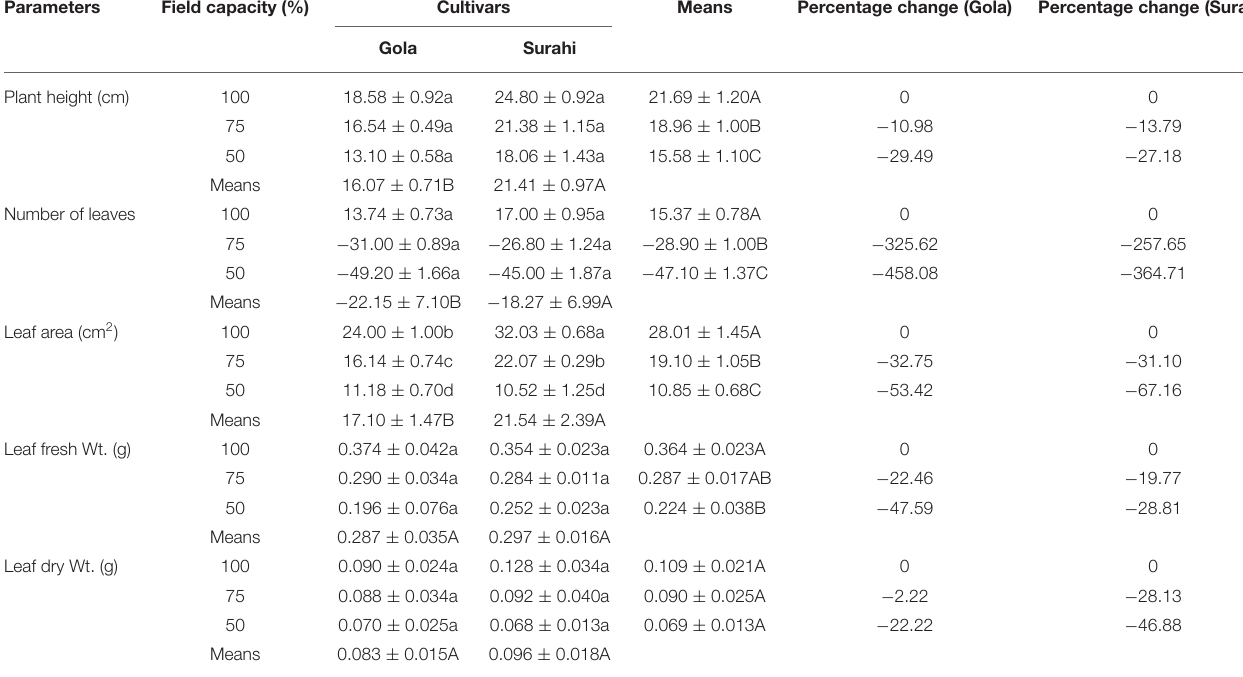
TABLE 1 | Net plant growth attributed in guava cultivars under drought stress.